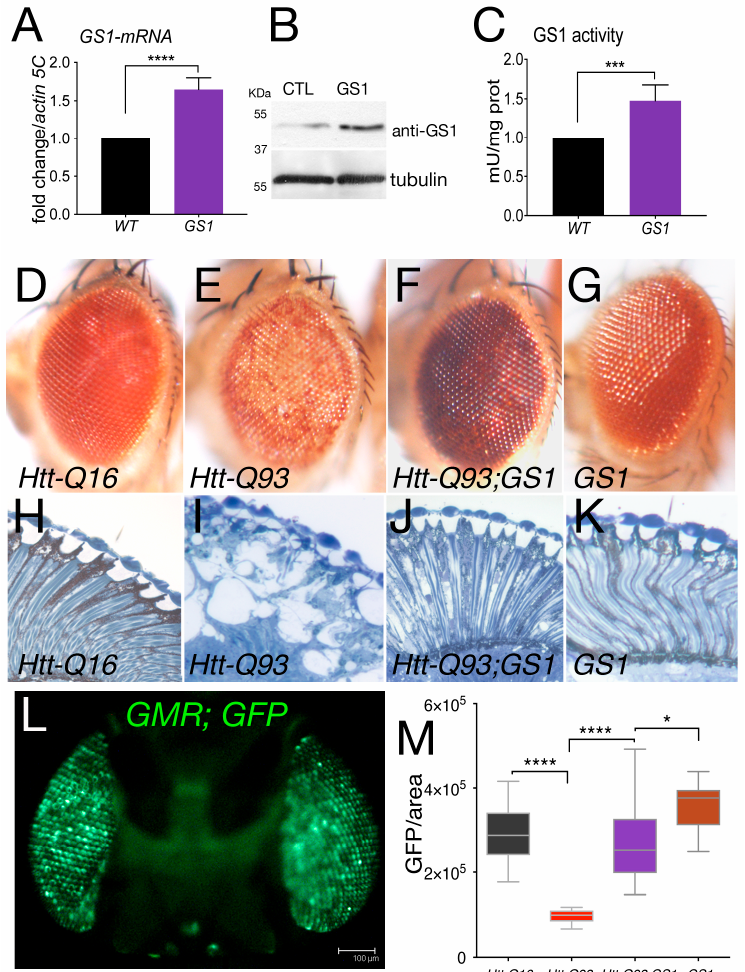
Figure 1. Expression of GS1 in the retina rescues neuronal death induced by Htt-Q93 . ( A ) Quantitative reverse transcription polymerase chain reaction (qRT-PCR) analysis of GS1 mRNA expression in larvae from control w 1118 of animals expressing the EP-GS1 G4337 (GS1) line using the actin-Gal4 driver. The relative level of GS1-mRNA is reported as arbitrary units compared to actin5C used as a control. At least three separate experiments were performed in duplicate. ( B ) Western blot from larvae extracts showing the relative amount of GS1 protein from w 1118 (CTL) animals or expressing GS1. Tubulin was used as the loading control. ( C ) GS1 enzymatic activity in extracts from whole larvae used in ( A , B ). *** p < 0.001, **** p < 0.0001 in panels ( A , C ) were calculated from Student’s t -test from at least three independent experiments.( D – G )) Photographs of Drosophila -compound eyes (lateral view) from females at 20 days after eclosion (DAE) expressing the indicated UAS -transgenes using the GMR-Gal4 driver. ( H – K ) Representative photographs of the retina from animals of the indicated genotype. ( L ) Fluorescent image of a fly head expressing UAS-GFP under the GMR-Gal4 promoter (sagittal view), bar 100 µ m. ( M ) Quantification of GFP from photographs of adult eyes at 20 DAE of the indicated genotypes. The asterisks represent the p -values from One-way analysis of variance (ANOVA) with Tukey multiple comparison * p < 0.05 and **** p < 0.0001, and the error bars indicate the standard